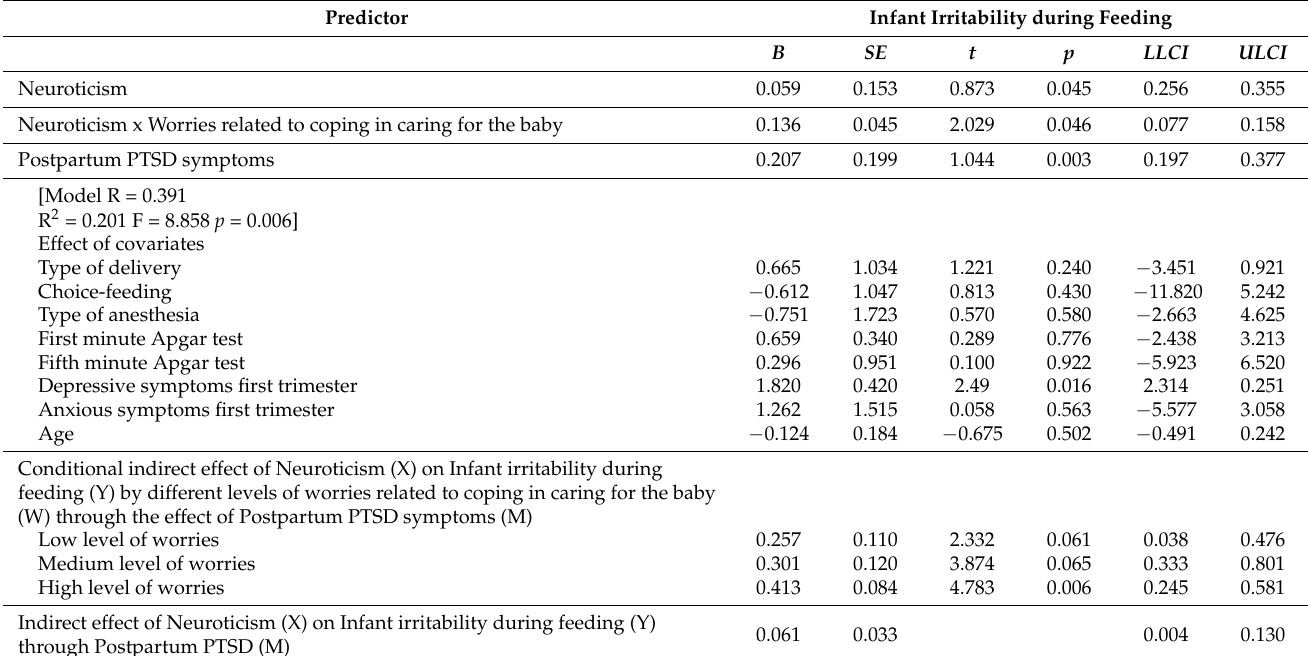
Table 4. Moderated-mediation model of neuroticism on infant irritability during feeding through P-PTSD symptoms (mediator), taking into account worries related to coping in caring for the baby